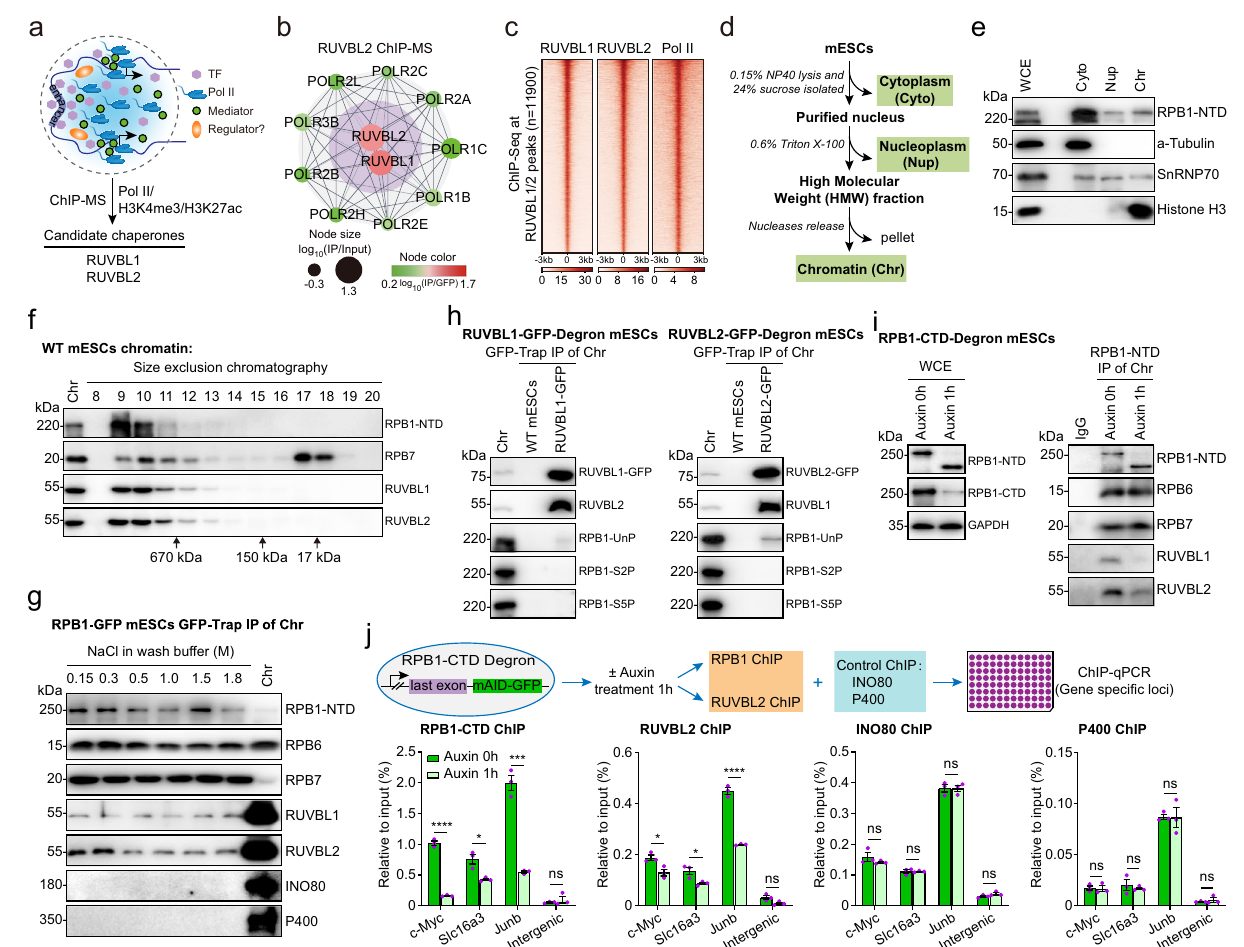
Fig. 1 | RUVBL2 interacts with RPB1 CTD on chromatin. a An illustration of the Pol II-mediated clusters. RUVBL1/2 were identi fi ed by Pol II, H3K27ac, and H3K4me3 ChIP-MS. b RNA polymerase I/II/III subunits were detected in RUVBL2 ChIP-MSpreparations.Thelinesindicatetheprotein-proteininteractionsdetected in the STRING database. c Heatmap illustrating that RUVBL1 and RUVBL2 globally colocalized with Pol II on the mESC genome. d Schematic diagram showing the subcellular fractionation (cytoplasm, nucleoplasm, and chromatin) procedure, which was adopted from Damianov et al. 112 . e Western blotting was performed